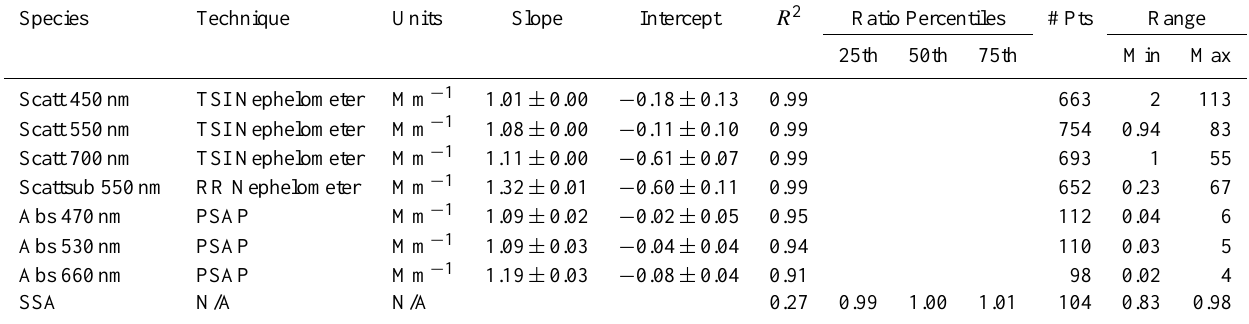
Table 3i. Statistical results of DC-8/C-130 intercomparison. Particle scattering and absorption. NOTE: Technique is listed as X (C-130) vs. Y (DC-8).